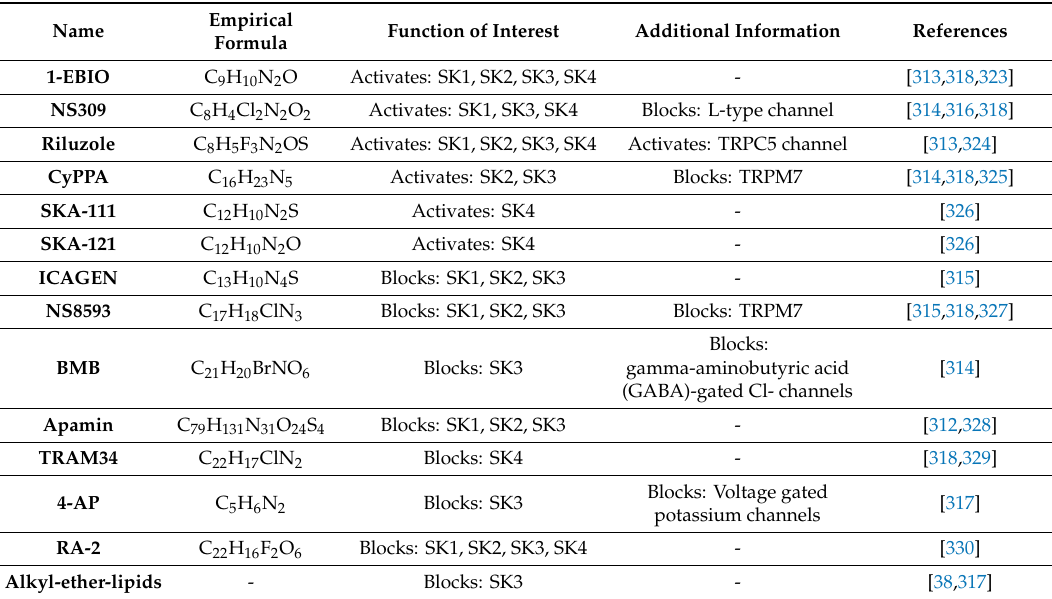
Table 3. SK channel modulators. This table summarizes the most common SK channel modulators together with their empirical formula, the function of interest and some additional